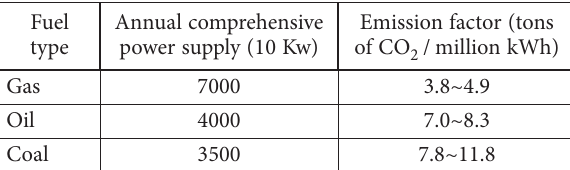
Table 5. Parameter settings of company agent